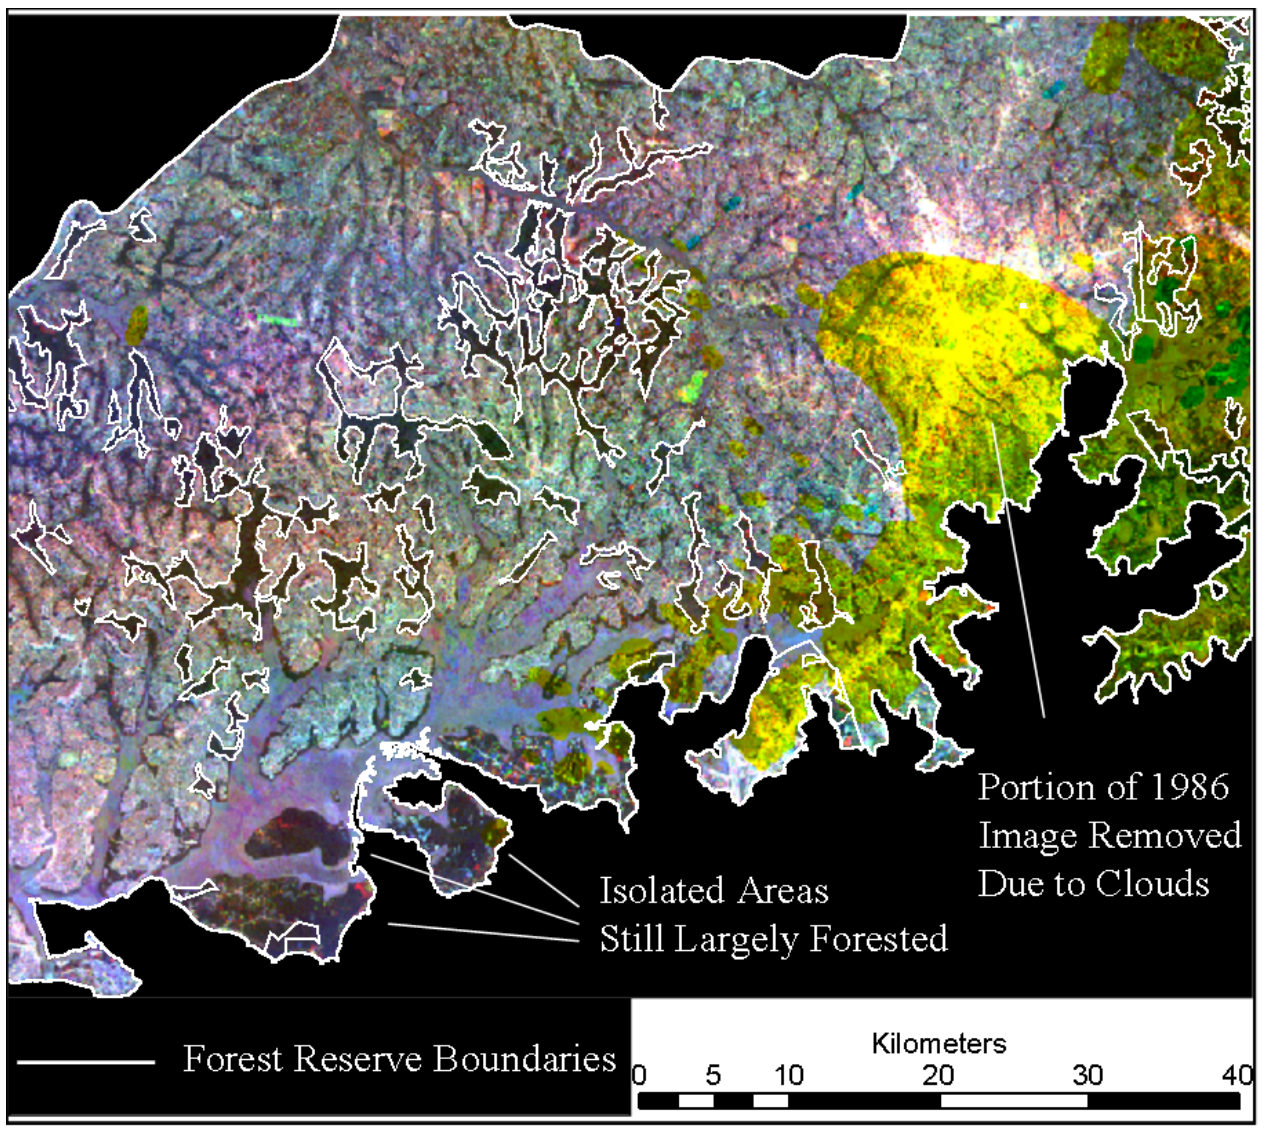
Fig. 2. Multitemporal composite illustrating general respect for boundaries of forest reserves located within the tropical forest biome of West Mengo. Vector coverages delineating forest reserve boundaries extracted from a 1955 topographic map are shown by white lines. The yellow area over Kampala is not due to clearing after 1986, but rather is a result of removal of that portion of the 1986 Landsat Thematic Mapper (TM) image due to clouds. White arrows point to isolated areas still mostly forested, demonstrating presettlement cover. This composite was generated with two Landsat TM images and one Landsat Enhanced Thematic Mapper (ETM+) image acquired in 1986, 1995, and 2002, respectively. The composite was constructed by Nathan